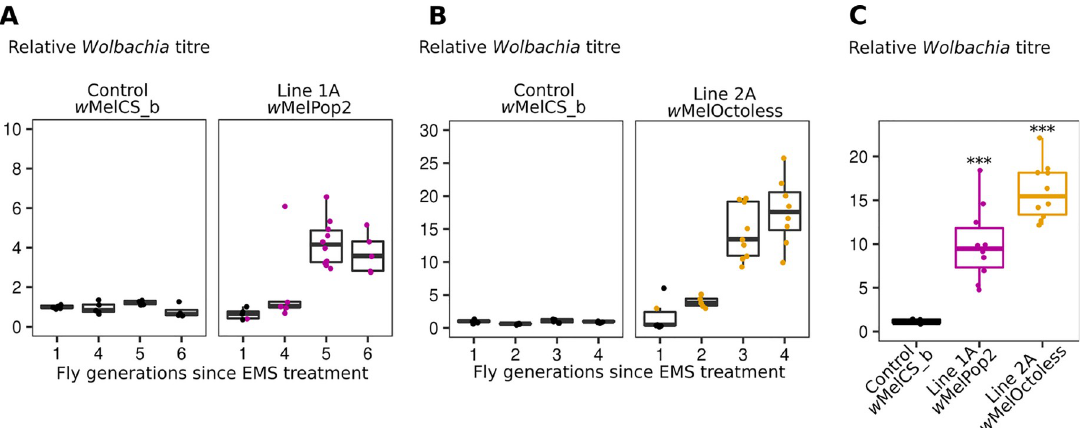
Fig 1. Isolation of over-proliferative Wolbachia variants by a forward genetic screen. (A and B) Relative Wolbachia titres in a control ( w MelCS_b) and EMS-treated flies (Lines 1A and 2A). 5–10 virgin females were randomly collected each generation for egg-laying and Wolbachia titre measurement using qPCR. Bacterial titres are normalized to that of control flies. The female used in the first generation to start the next generation is coloured. At the other generations the progeny of the female with the higher Wolbachia titre was used to set up the next generation. The selection of the other putative over-proliferating Wolbachia line in panel B is shown in S3A Fig. (C) Relative titres of over-proliferating Wolbachia variants in a host isogenic genetic background. Both lines kept the over-proliferative phenotype ( p < 0.001). Each dot represents the Wolbachia titre of a single female.